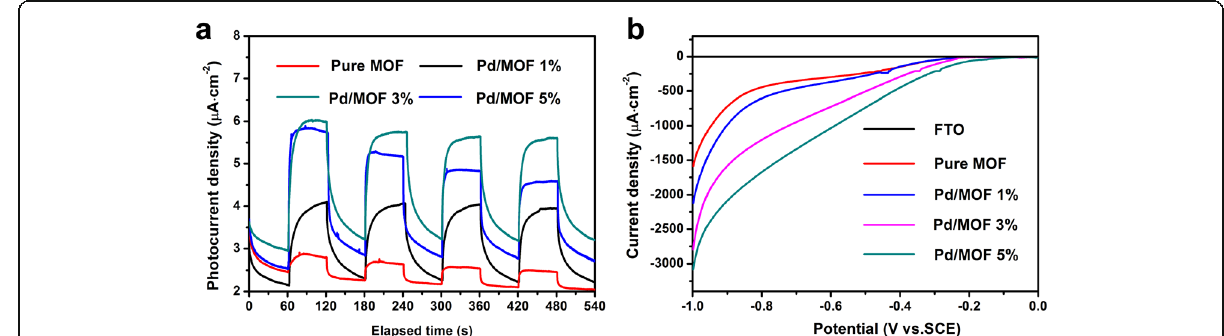
Fig. 12 a Transient photocurrent responses for samples of MOF, Pd/MOF 1%, Pd/MOF 3%, and Pd/MOF 5% in 0.2 M Na 2 SO 4 aqueous solution under visible-light irradiation ( λ ≥ 420 nm) at 0.4 V vs. SCE. b Linear sweep voltammograms of MOF, Pd/MOF 1%, Pd/MOF 3%, and Pd/MOF 5%